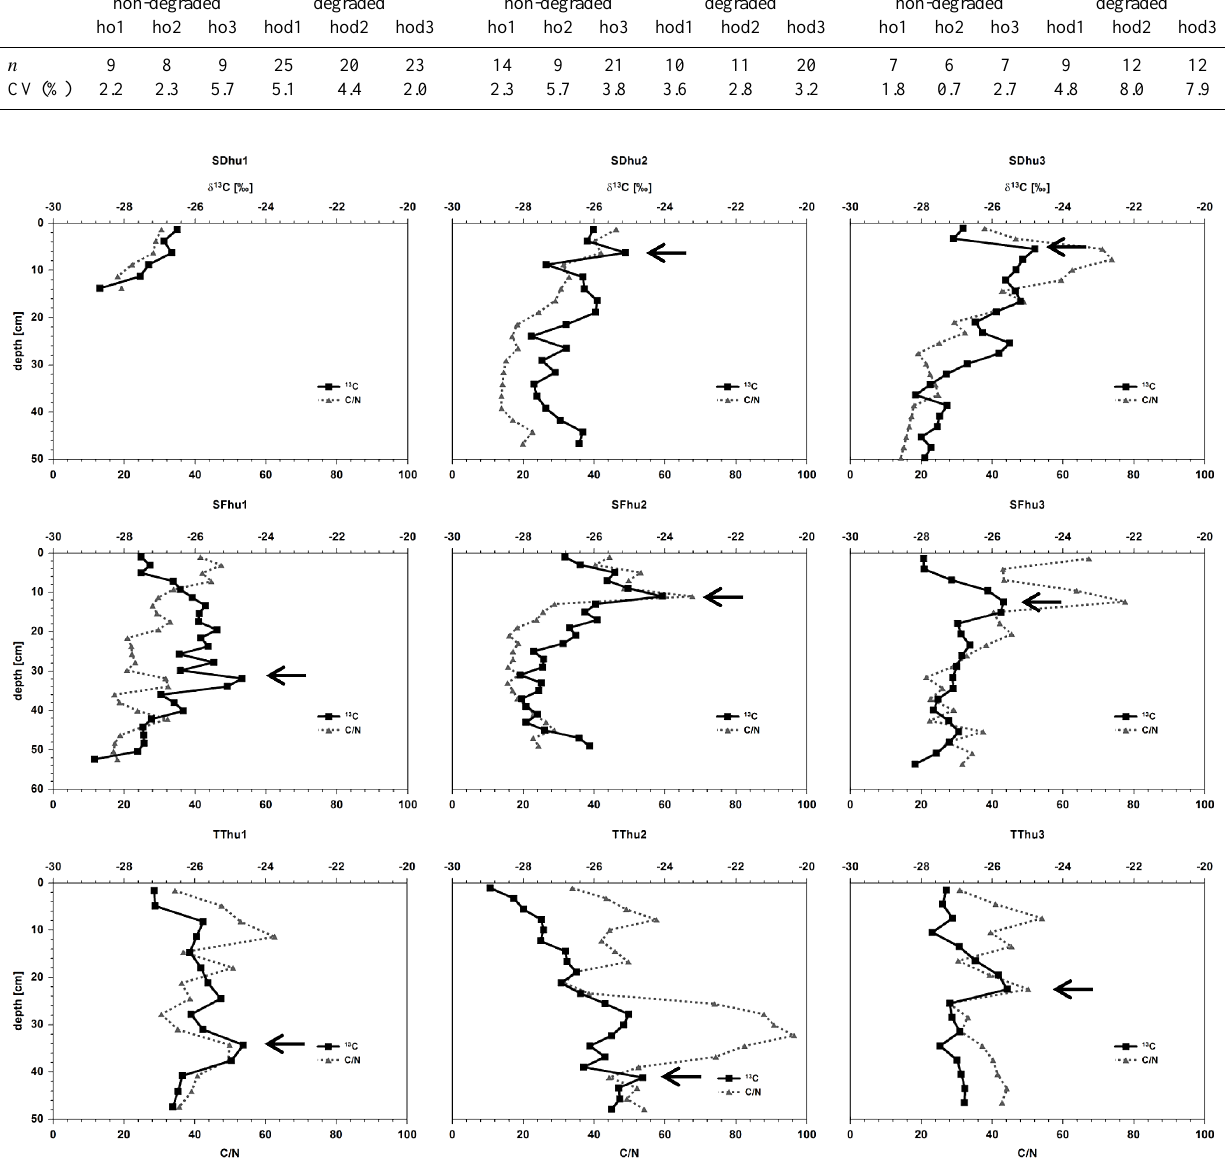
Figure 3. δ 13 C and C/N ratio in depth profiles of hummocks (hu) at Stordalen (SD), Storflaket (SF) and Torneträsk (TT) peatland. Turning points in the profiles are indicated with black